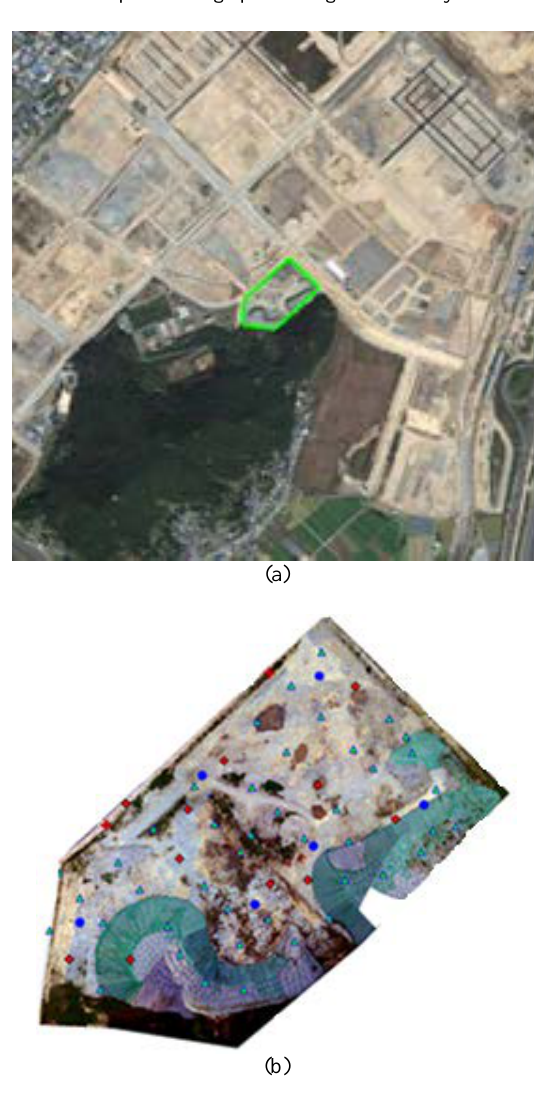
Figure 2. The experiment was conducted in the area of a new town project, with a very low likelihood of UAV crash or other such accidents. (a) Aerial view of the region in which the UAV images were taken. The central area (marked in green) is where the experiment was conducted. (b) Distribution of the locations of GPS base stations, 3D laser scanner, and GCPs on the final ortho-images of the experimental